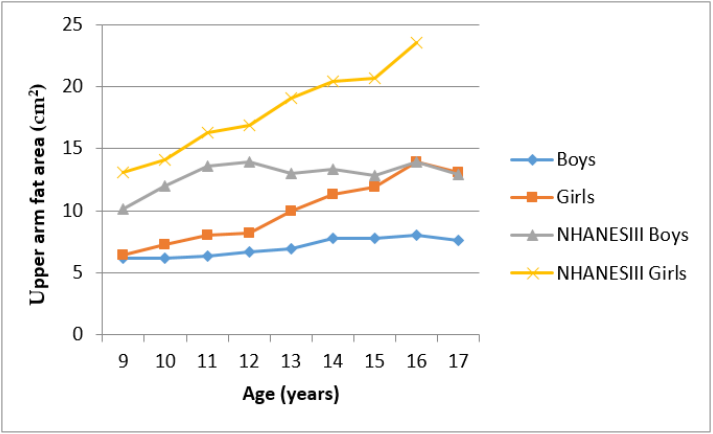
Figure 4. Mean upper arm fat area of Ellisras children compared to the NHANES III reference population aged 9–17 years.